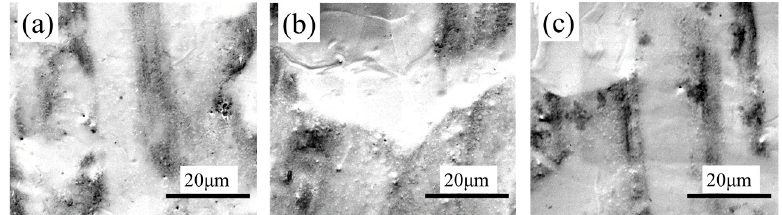
Figure 2. SEM images (5000×) of tinplate treated with ( a ) reflowing before passivation, ( b ) chemical passivation, and ( c ) electrolytic passivation.